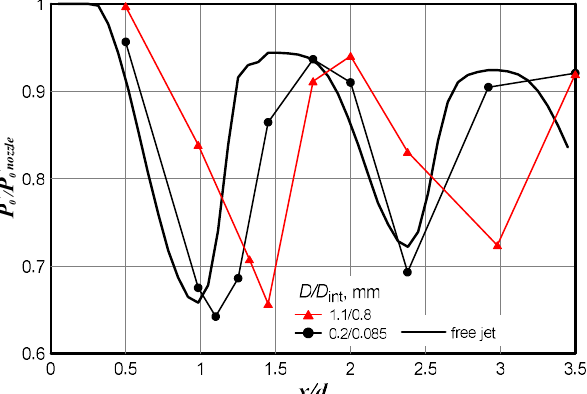
Figure 6. Calculation of the model microjet escaping from the nozzle 1.06 mm in diameter (modeling exhaustion from the nozzle 16.1 µm in diameter) and impinging onto the Pitot tubes of different diameters.